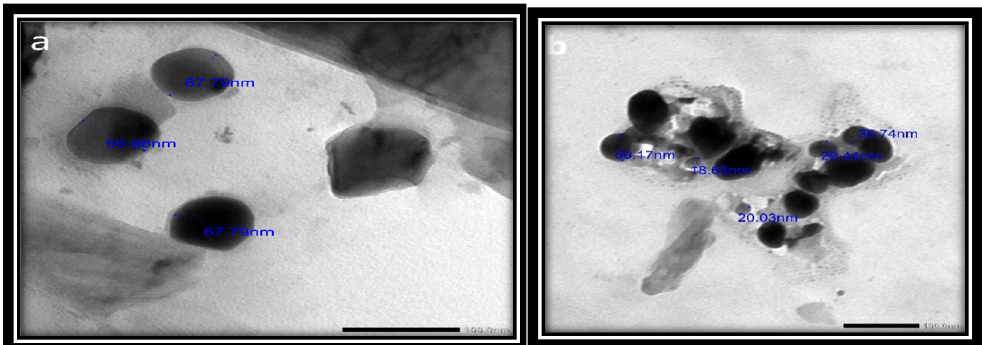
Fig. 5 a & b. TEM photographs of USeNPS Figure 5. ( a , b ) TEM photographs of USeNPS (100 nm). Figure 5. ( a , b ) TEM photographs of USeNPS (100 nm).